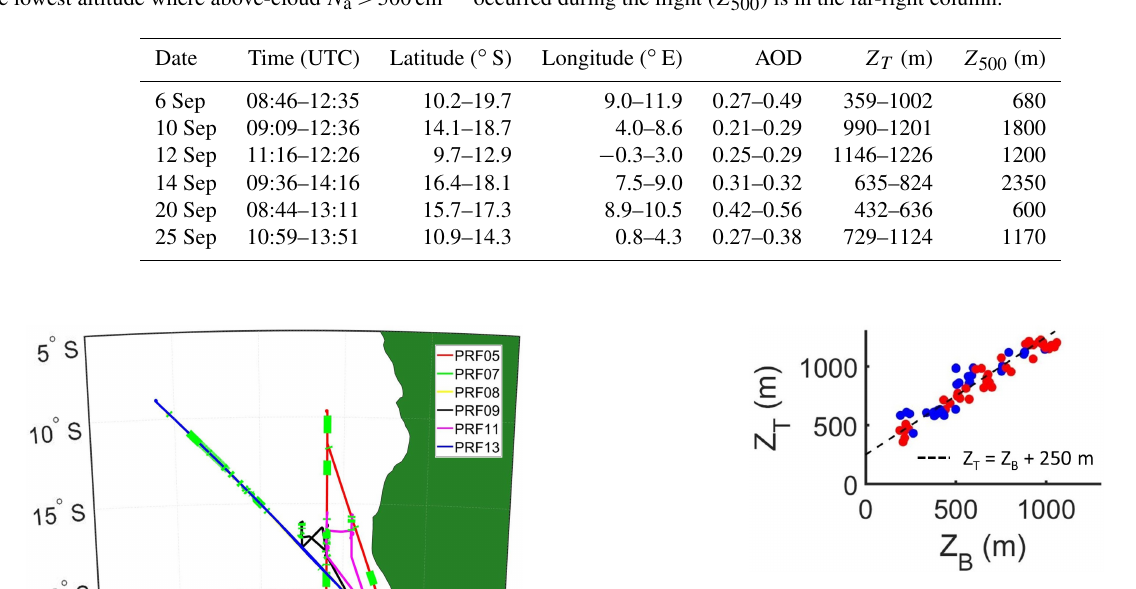
Figure 9. Cloud base and top heights for contact (blue) and sepa- rated (red) profiles flown during the six